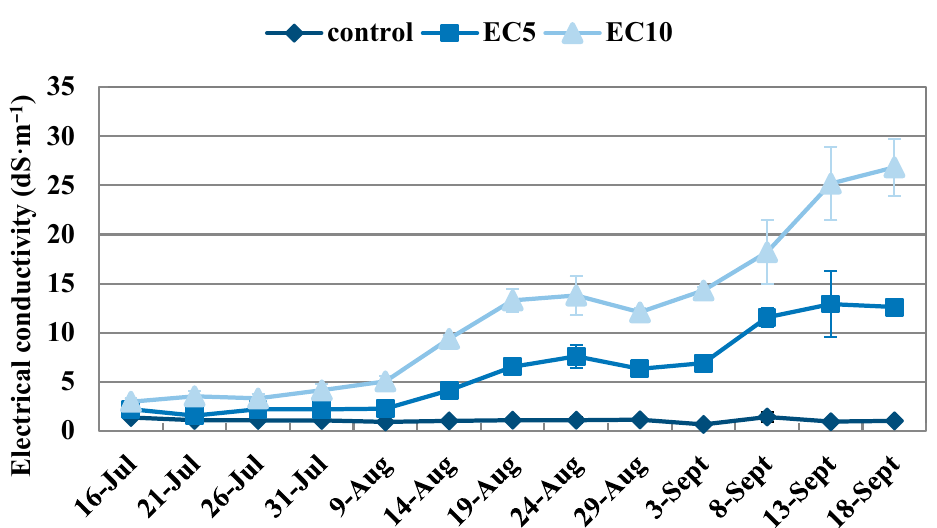
Figure 1. Leachate electrical conductivity (EC) from 16 July to 18 September 2018. Control, EC5, and EC10 correspond to the respective treatments of irrigation solution: tap water (control), EC of 5 dS · m − 1 , and 10 dS · m − 1 , respectively. Vertical bars represent standard error